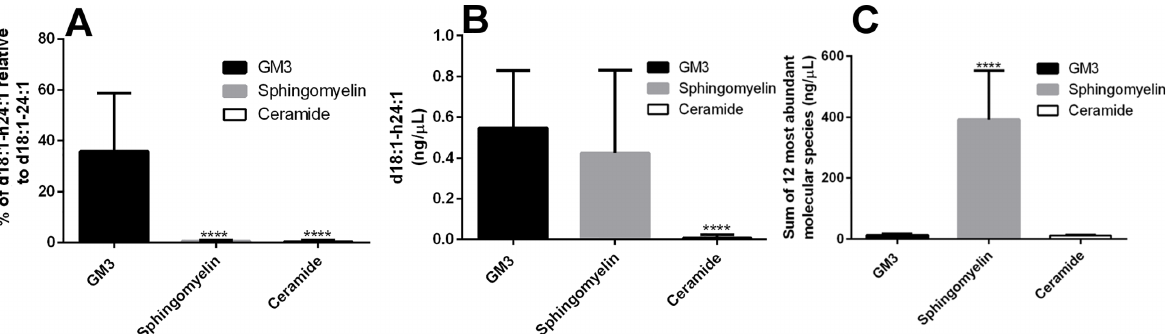
Fig 6. The relative abundance of d18:1-h24:1 molecular species. Percent of d18:1-h24:1 relative to d18:1 – 24:1 in GM3, sphingomyelin and ceramide in individuals with metabolic disease (A). The average amounts of d18:1-h24:1 (B) and the sum of the 12 most abundant molecular species (C) of GM3, sphingomyelin and ceramide in six microliters of human serum from individuals with metabolic disease. Data are reported as means ± SD. **** P (cid:3) 0.0001 sphingomyelin and ceramide vs. GM3; Mann-Whitney unpaired